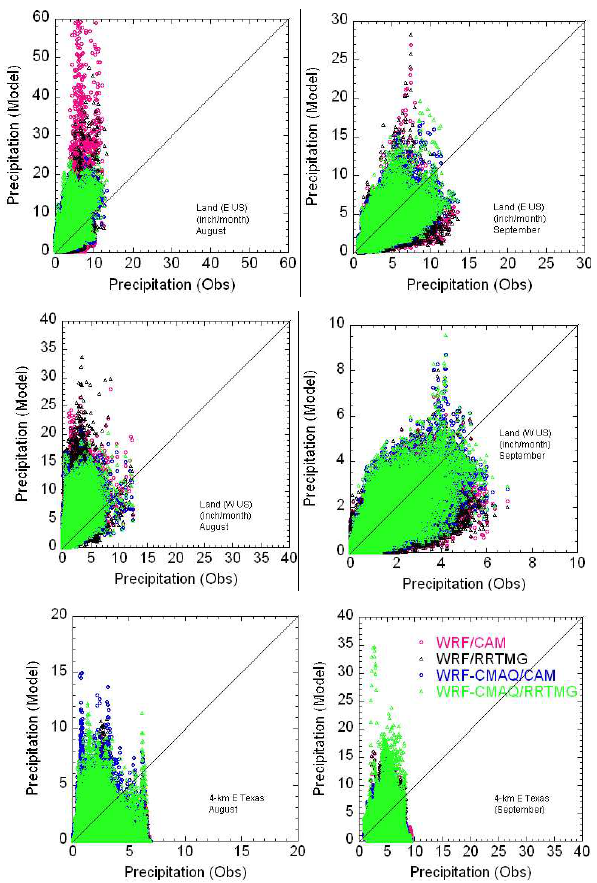
Figure 26. Scatter plots of modeled (WRF-CMAQ/CAM, WRF-CMAQ/RRTMG, WRF/CAM and WRF/RRTMG) and observed monthly mean precipitation (inch/month) over the land of the eastern and western U.S. for the 12-km resolution simulations and over the eastern Texas domain for the 4-km resolution simulations for August and September of 2006.